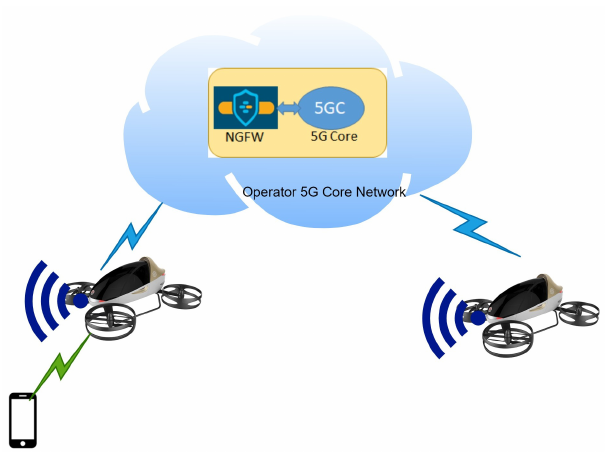
Figure 5. UAVs acting as aerial platform (BS) using UxNB access nodes.